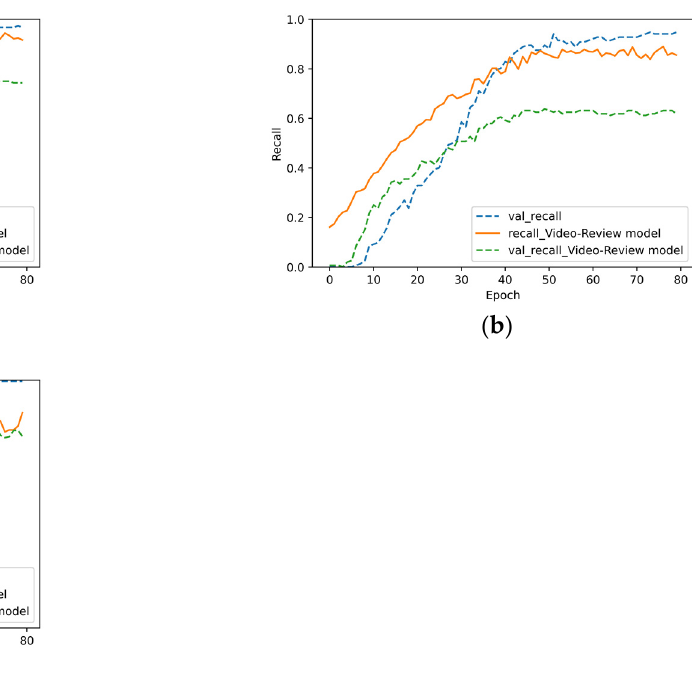
Figure 7. Experimental results of the video–review model: ( a ) accuracy, ( b ) recall, and ( c ) F 1 score.